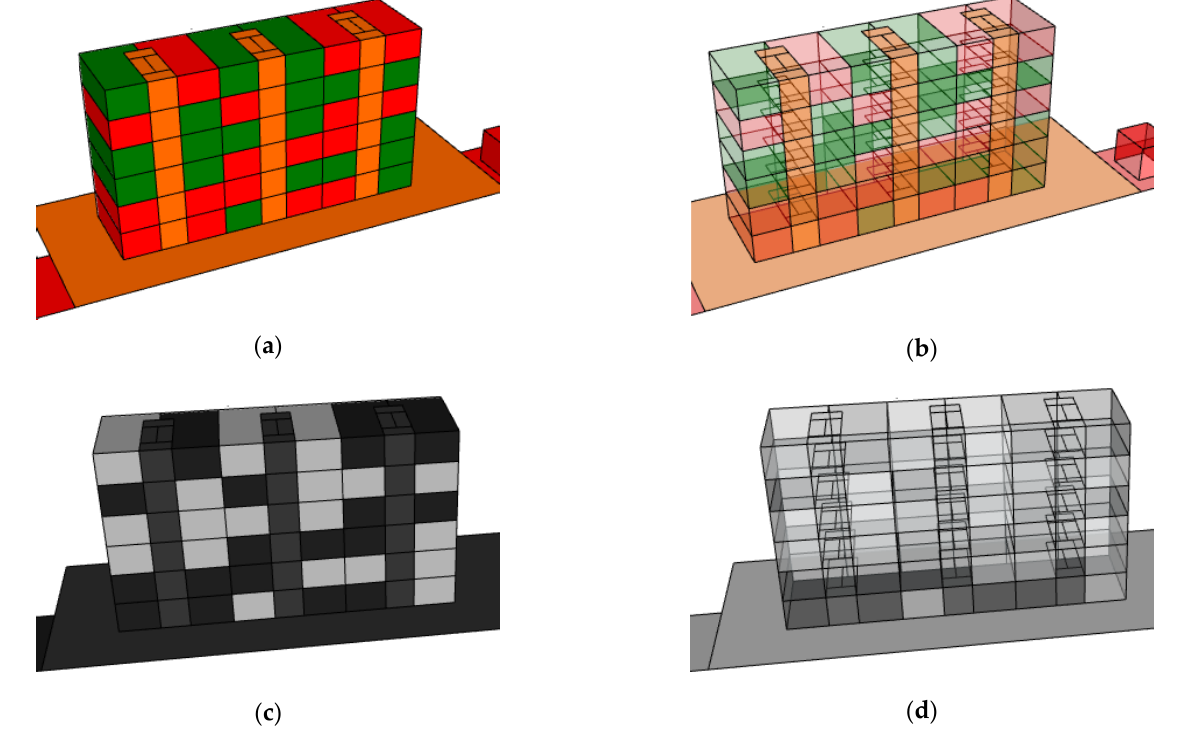
Figure 3. Visualization of the test model: ( a ) colorful, without transparency; ( b ) colorful, with transparency; ( c ) grayscale, without transparency; ( d ) grayscale, with transparency.